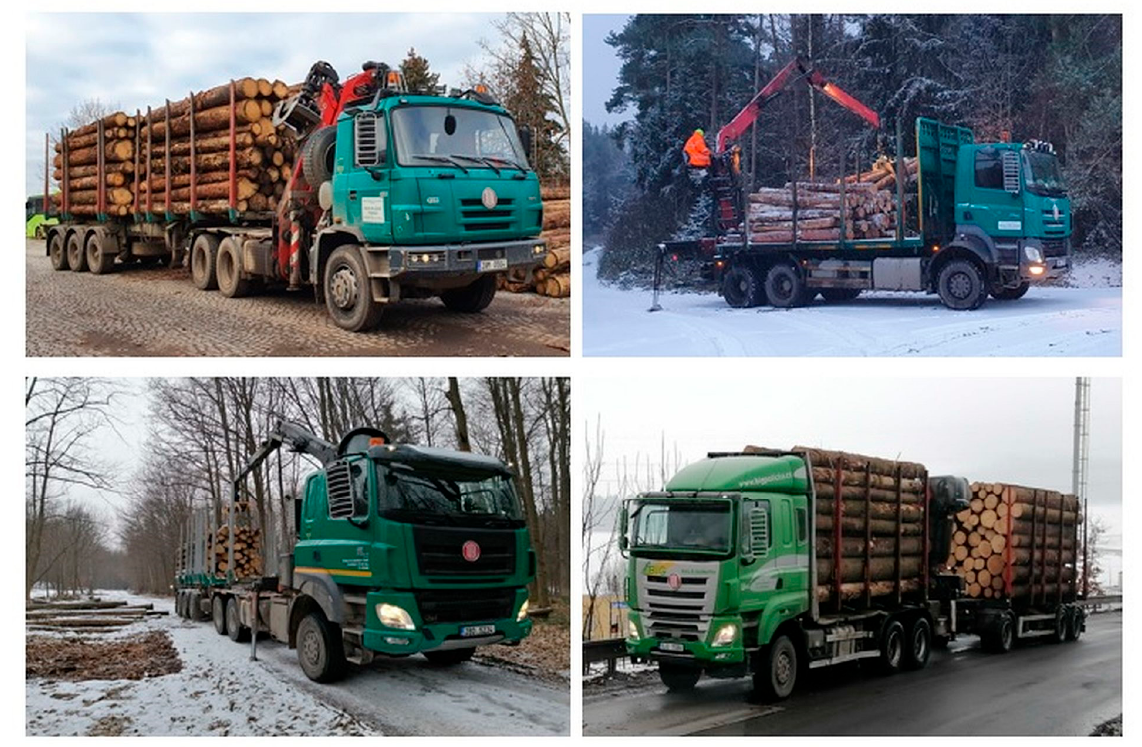
Figure 1. Vehicles used in the experiment. From left up Tatra 815, Tatra Phoenix I. and down Tatra Phoenix II. (Author).